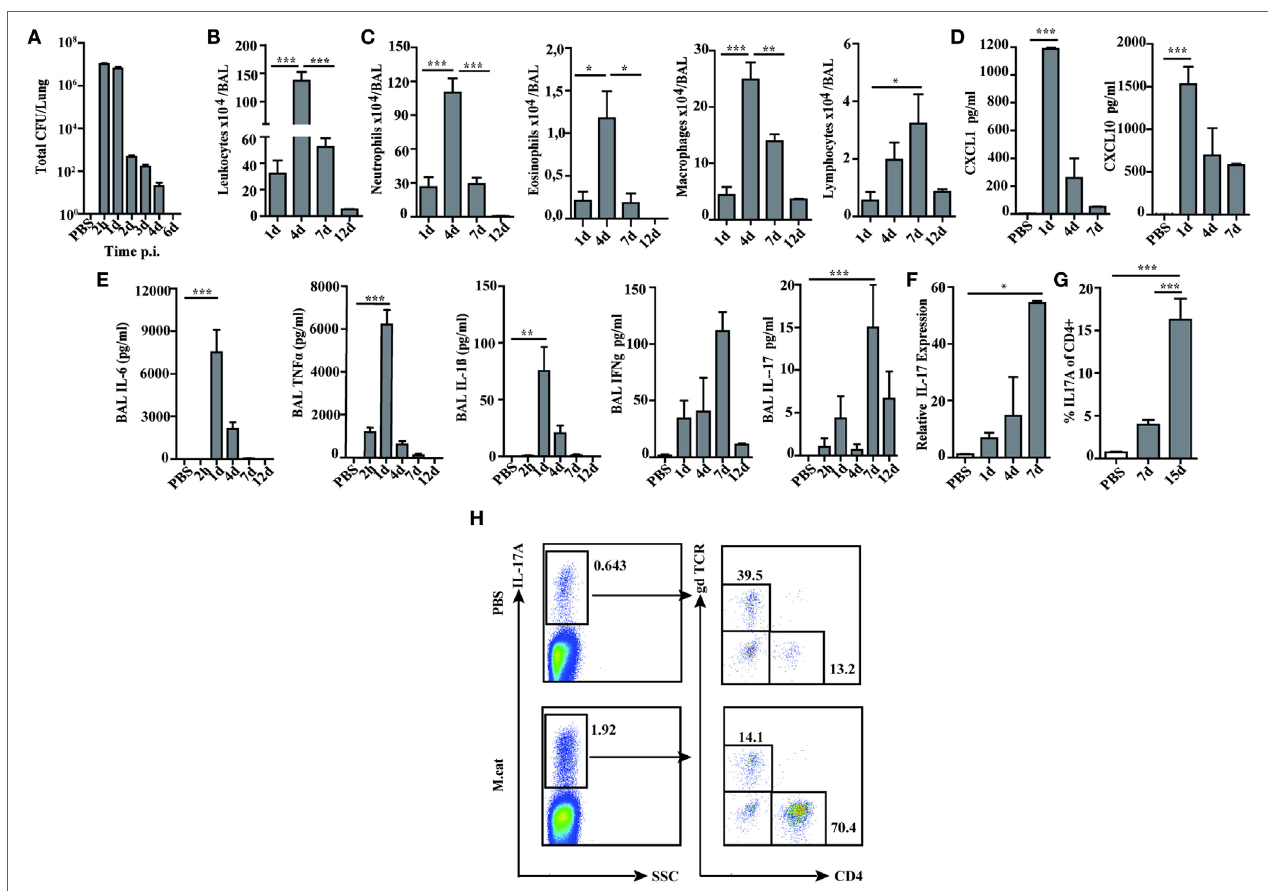
FigUre 1 | Pulmonary immune response after intranasal M. catarrhalis infection. C57Bl/6 animals were infected (i.n.) with 2 × 10 8 CFU M. catarrhalis and BAL and lungs were harvested at indicated time points. (a) Bacterial CFU were determined in lung homogenates. (B) Total cell counts in BALF. (c) Differential cell counts in BALF. (D) CXCL1 and CXCL10 chemokines in BALF. (e) Cytokines in BALF. (F) Quantitative expression of IL-17 mRNA (qPCR) in lungs. (g) Frequency of IL-17A + CD4 + T cells in lungs. (h) Analysis of γδ T cells and CD4 + T cells secreting IL-17A at day 7 after PBS treatment or infection. n = 6 mice per group and two independent experiments were performed. *** P = 0.001, ** P = 0.01, and * P = 0.05 (one-way ANOVA). BAL, bronchoaleveolar lavage; BALF, BAL fluid; qPCR, quantitative polymerase chain reaction; PBS, phosphate-buffered saline; ANOVA, analysis of